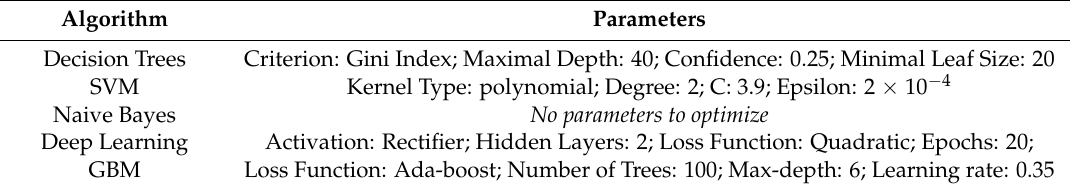
Table 5. Parameter values, upon completion of the parameter tuning process for Experiment B.